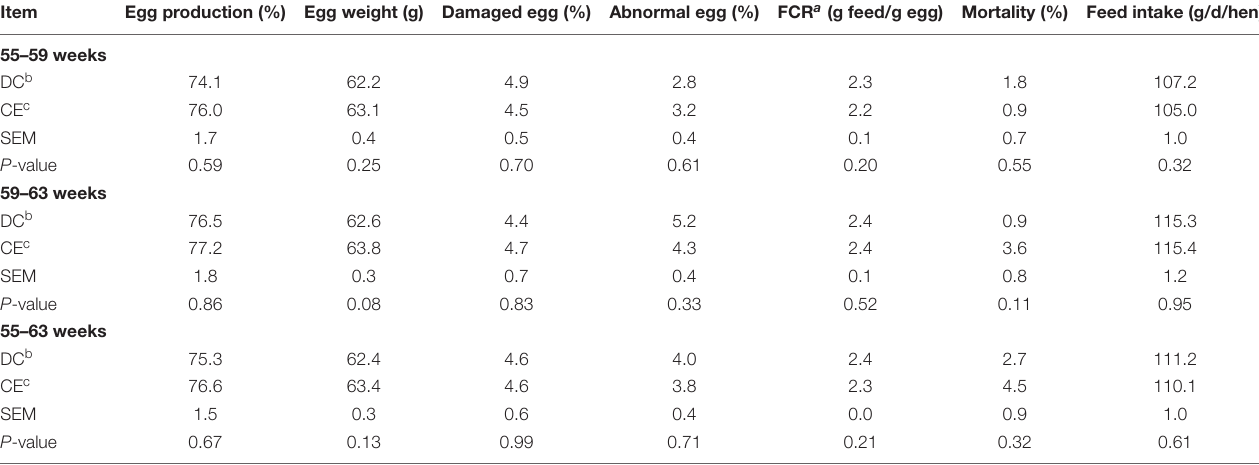
TABLE 2 | Effect of supplemental multi-enzyme on the performance of aged breeding hens. Item